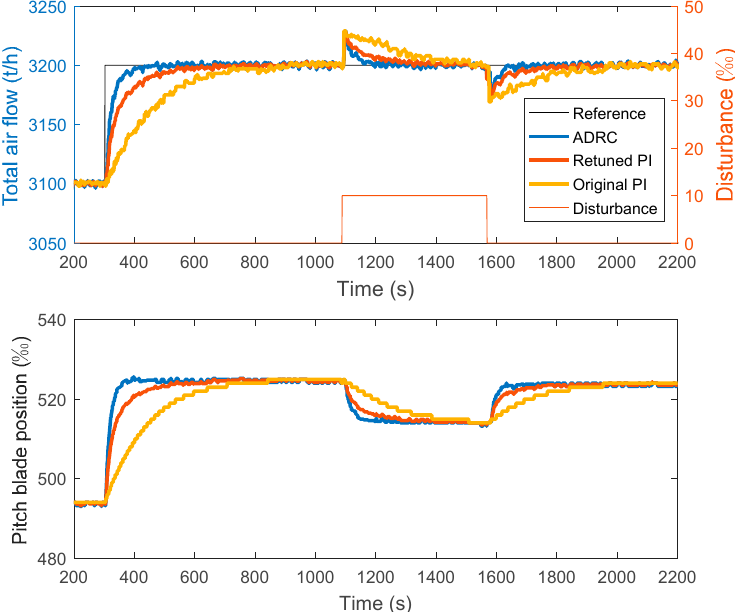
Figure 9. Set-point tracking and disturbance rejection tests of the total airflow control.